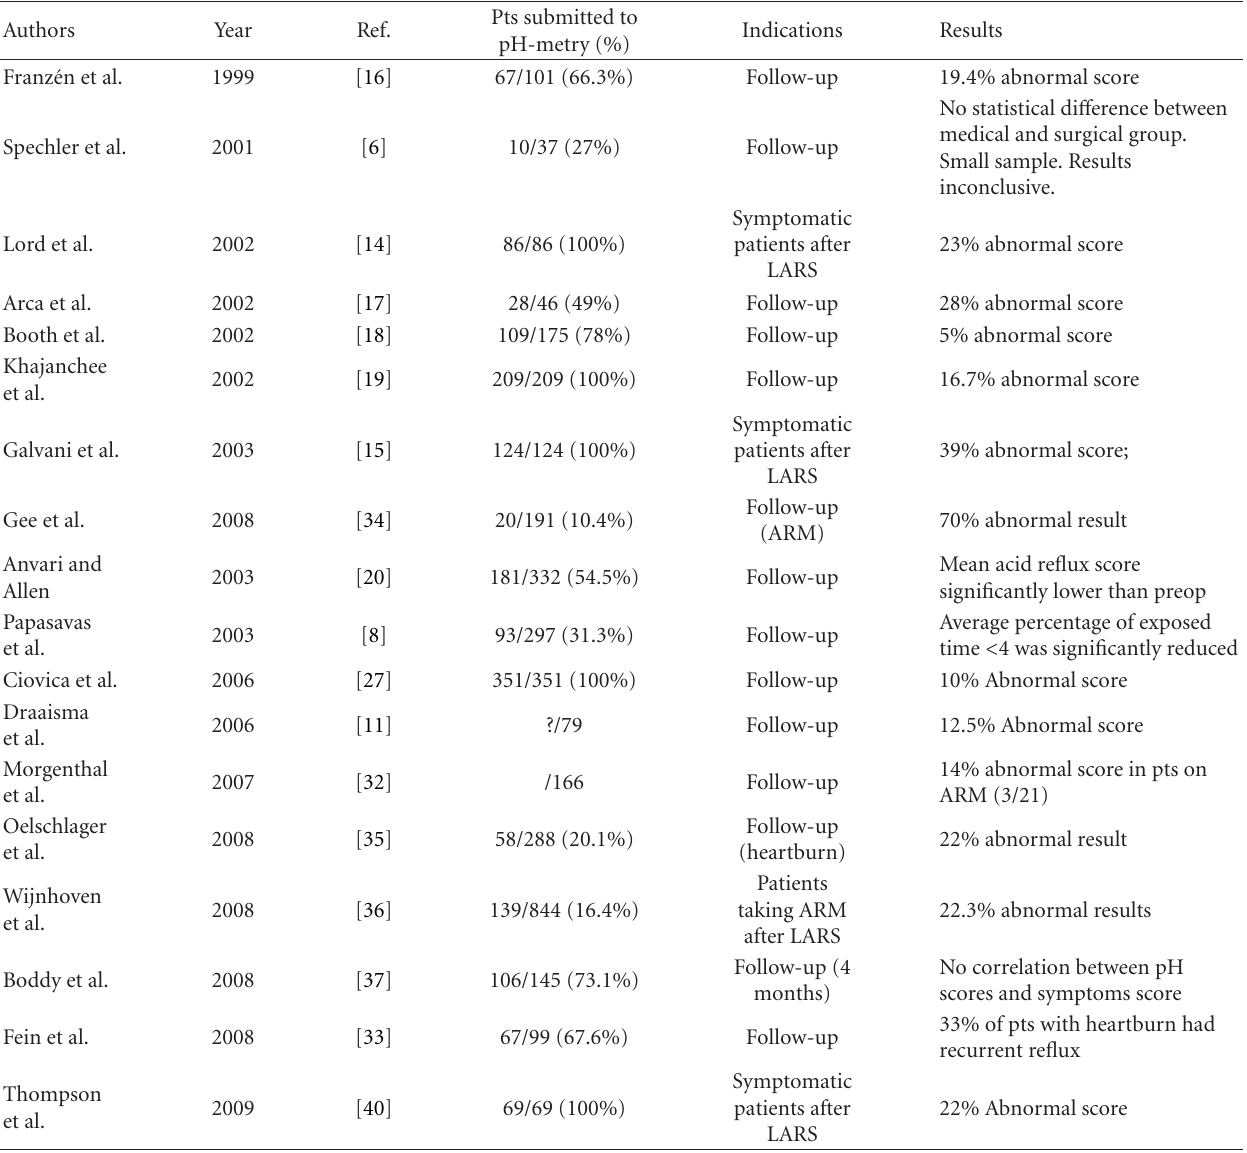
Table 4: Postoperative 24 hrs pH-metry. Indications and results.